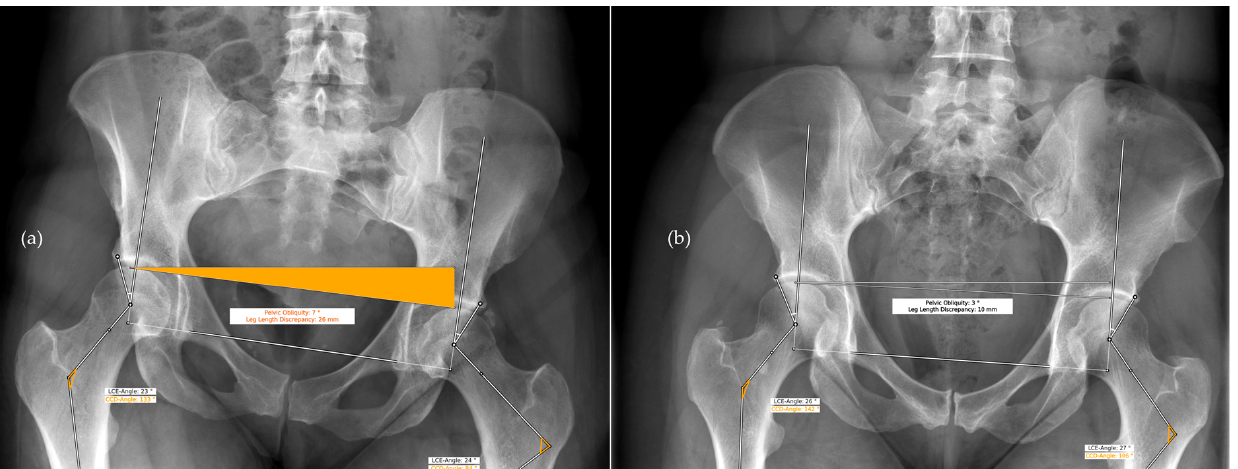
Figure 5. Deviation from the median for each individual observation for all readers and HIPPO™.